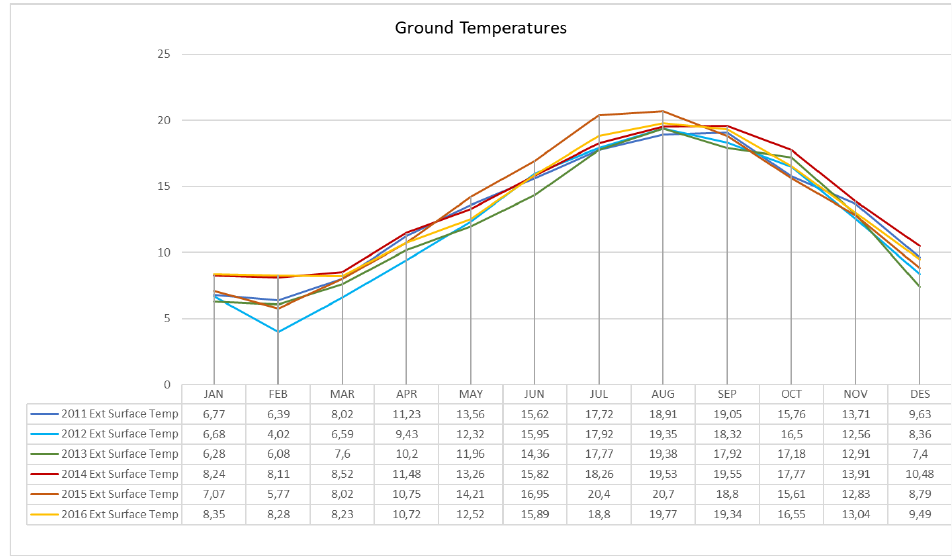
Figure 10. Ground temperatures.